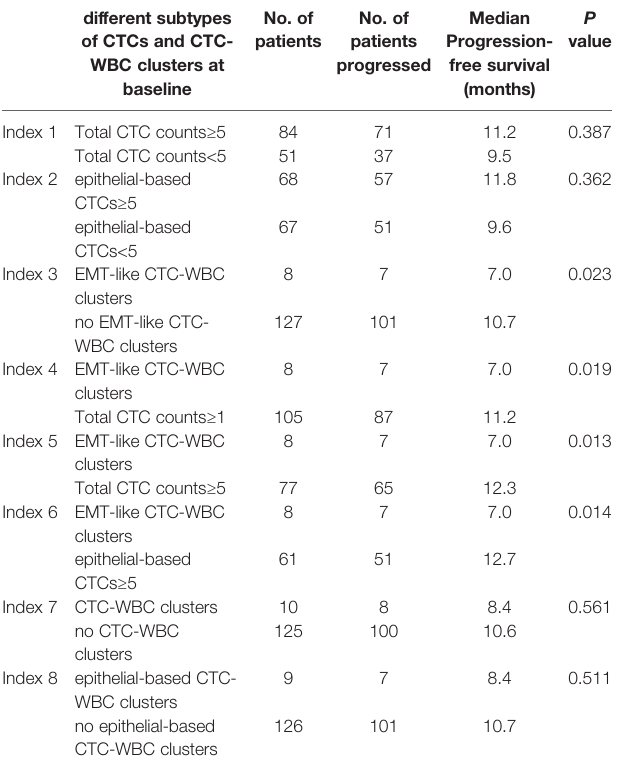
TABLE 3 | Detail description of Kaplan-Meier analysis-based estimation of Progression-free survival for different subtypes of CTCs and CTC-WBC clusters at